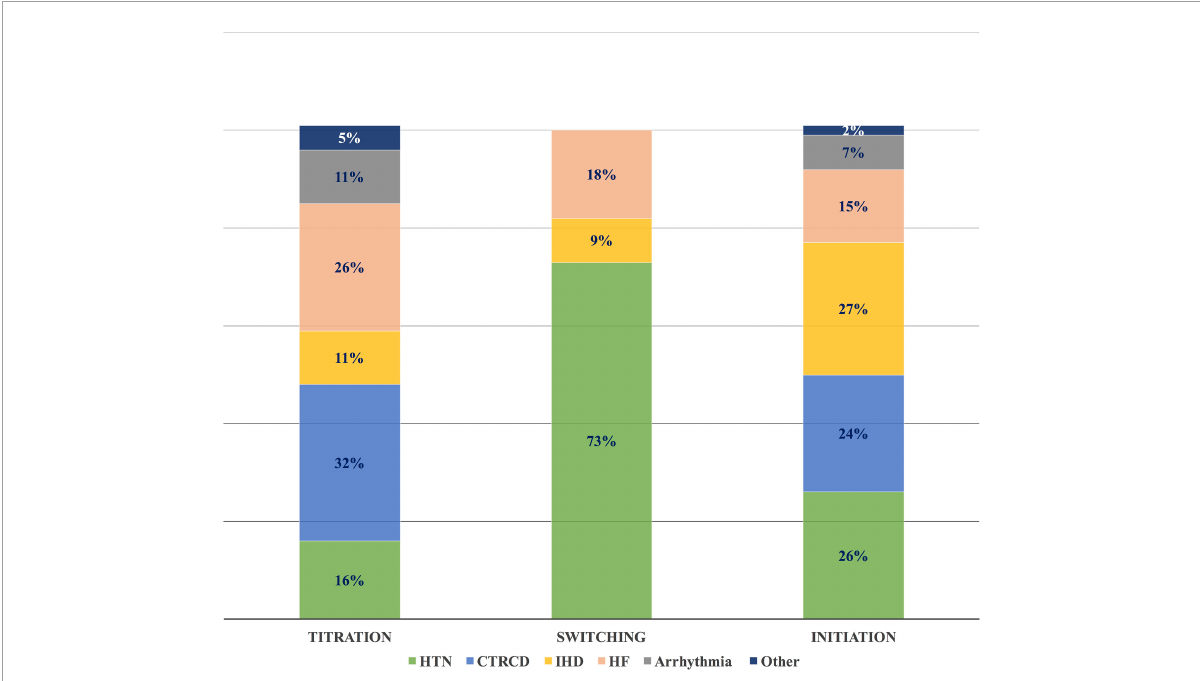
FIGURE8 Frequency of different CVRF/CVD in different types of drug interventions. The most common drug interventions in different CVRF/CVD cases were dose titration in CTRCD, switching between drugs in HTN, and drug initiation in IHD. CVD, cardiovascular disease; CTRCD, cancer therapy-related cardiac dysfunction; CVRF, cardiovascular risk factor; HF, heart failure; HTN, hypertension; IHD, ischemic heart